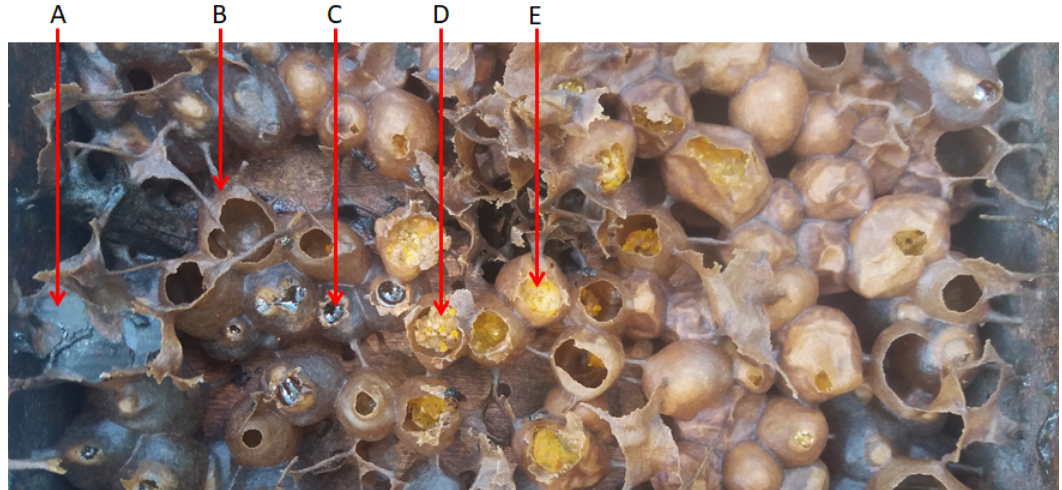
Figure 2. Hive box containing colony of stingless bees ( Heterotrigona itama ). A, cerumen; B, empty propolis pot; C, honey; D, bee pollen; E, fermented pollen (beebread).